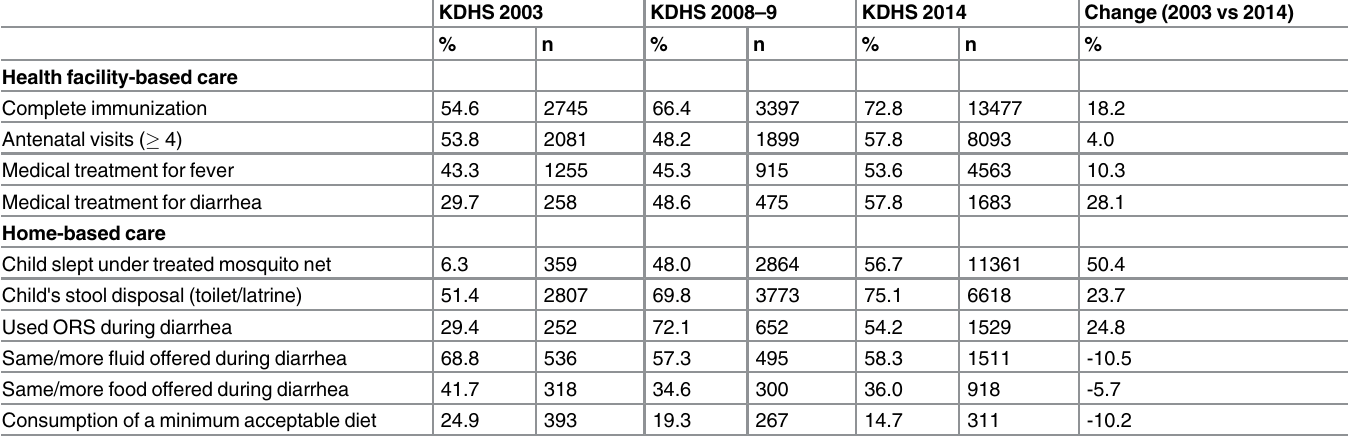
Table 2. National patterns: Health facility- and home-based optimal childcare